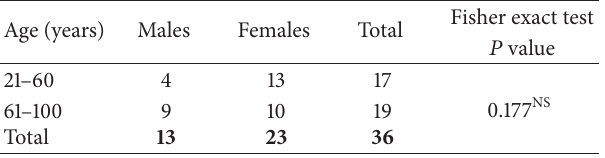
Table 1: Age-sex distribution of BCC.